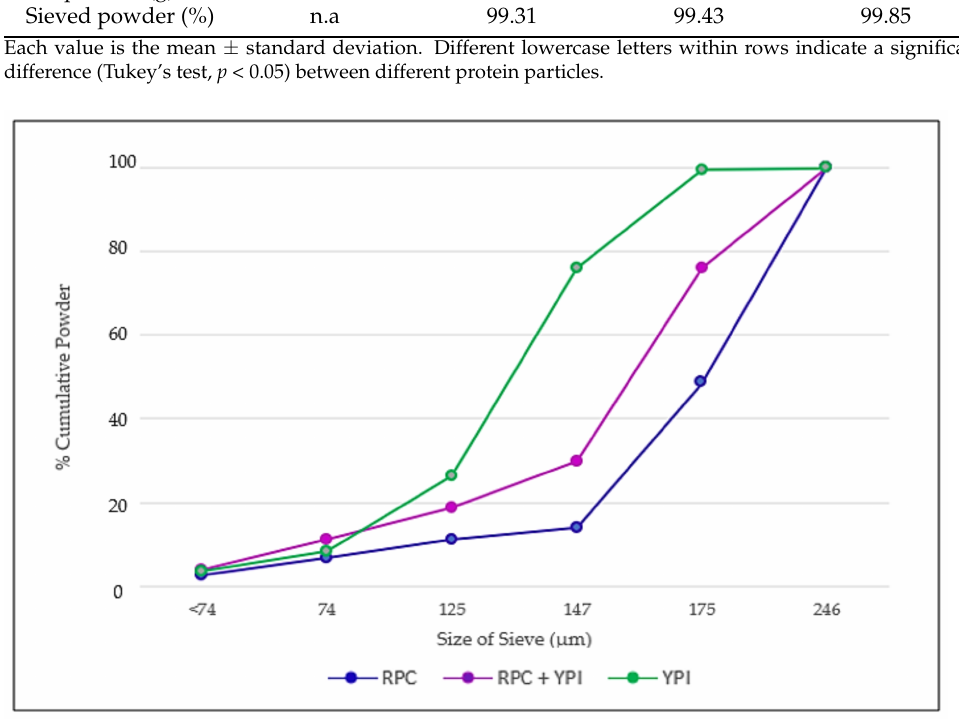
Figure 2. Graphical representation of the percentage of cumulative powder at the different sizes of sieves for all three different protein powder